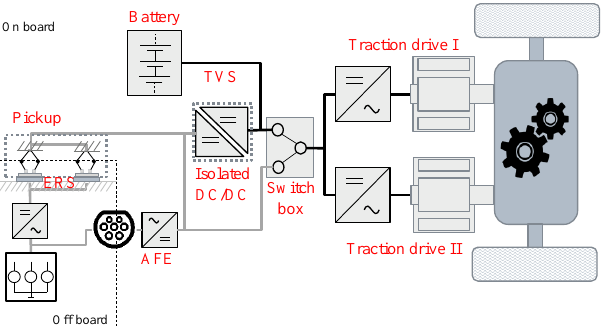
Figure 3. Schematic view of a powertrain with a low power DC-DC converter as well as a switch box (LSETS) [9].